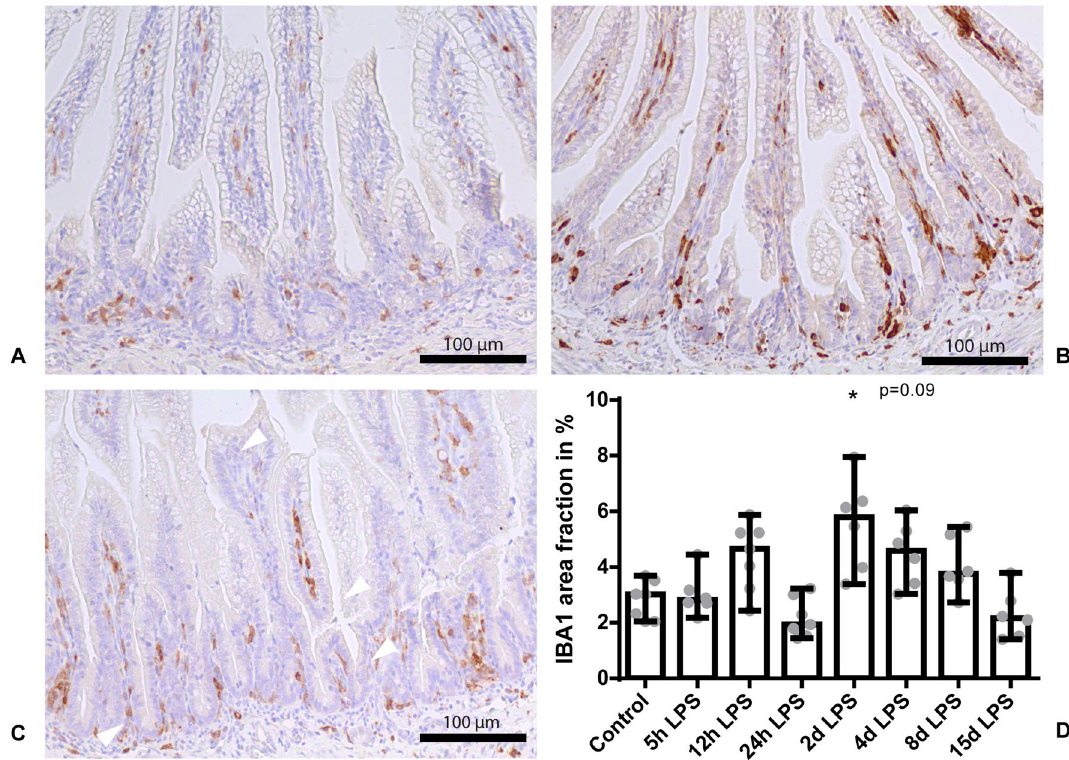
Figure 8. IBA1 immunoreactivity in the terminal ileum. Representative images of control ( A ), at day 2 after IA LPS administration ( B ) and at day 4 after LPS administration ( C ). Data are presented as medium with IQR ( D ).